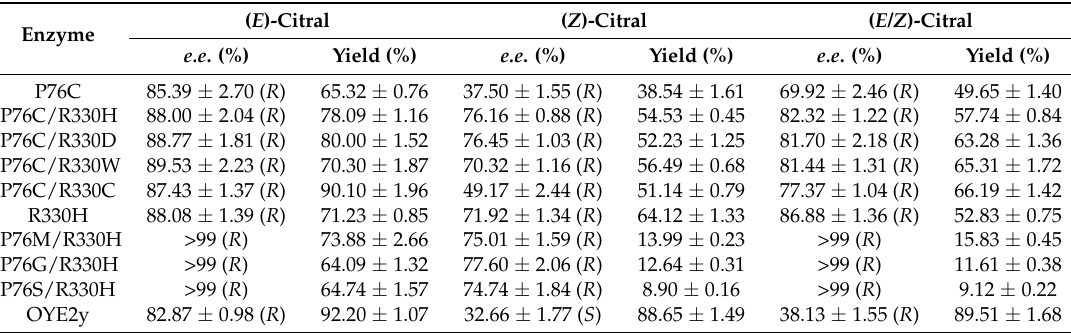
Table 4. The catalytic performance of double substitution variants of OYE2y at sites P76 and R330 a .